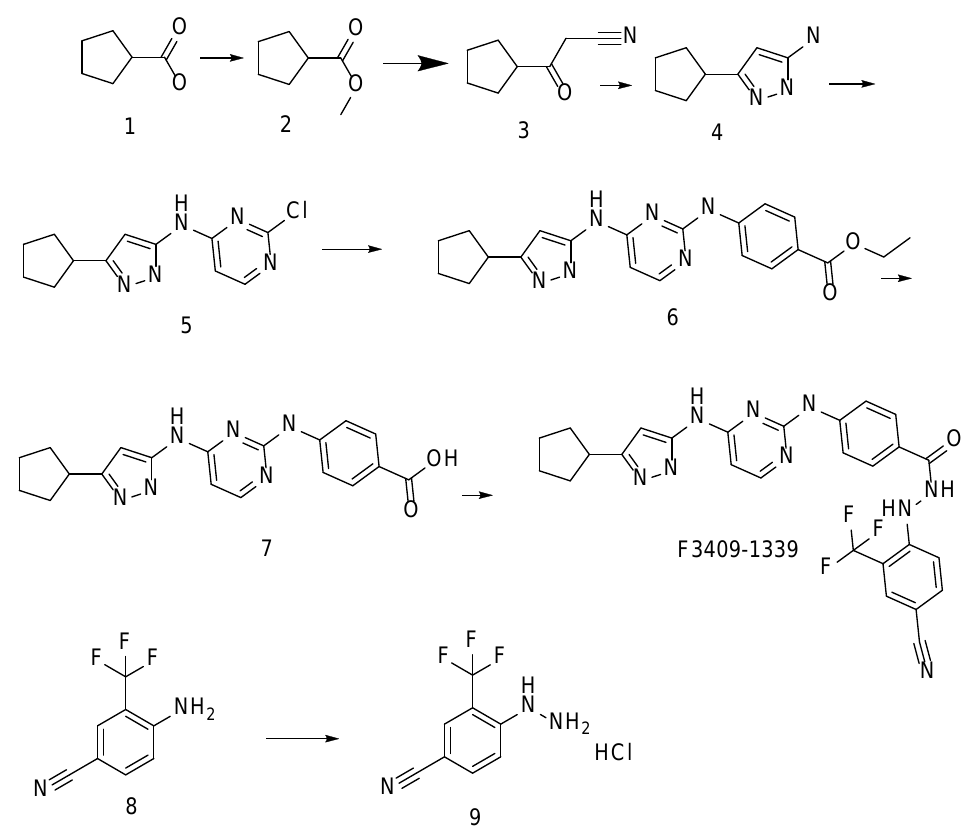
Figure A1. Synthetic Procedures for Synthesis of Compounds F3409-1339.